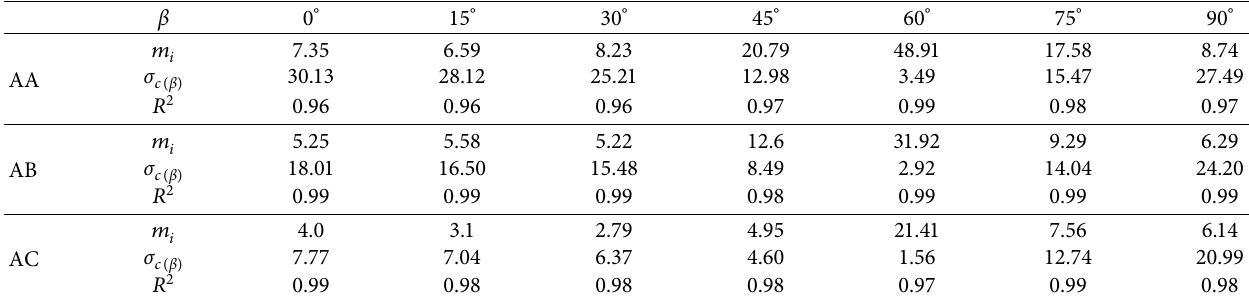
Table 4: The calculated coefficients of the Hoek–Brown empirical